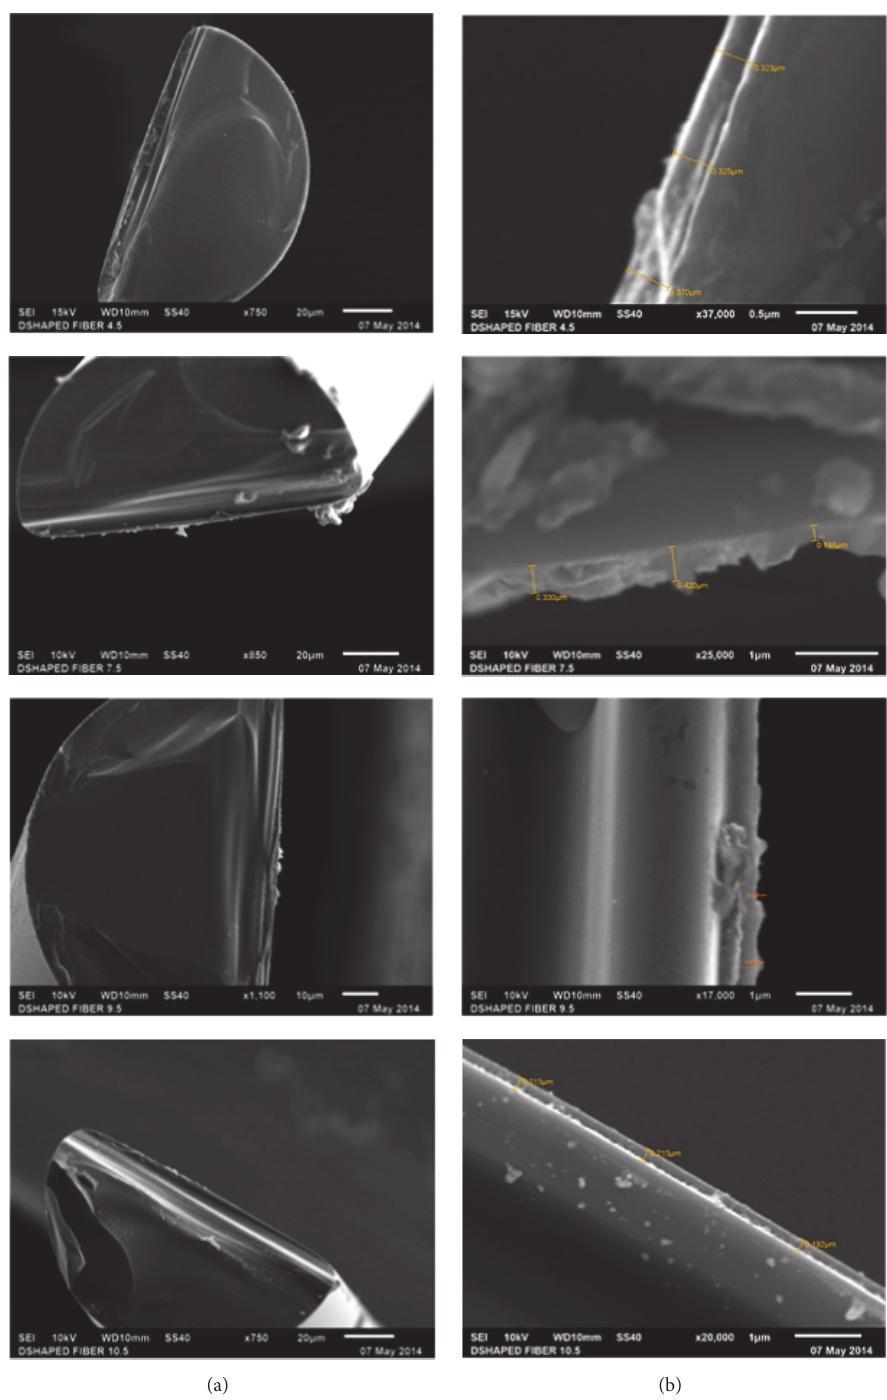
Figure 9: The SEM pictures of the D-shaped fiber coated with nanostructured metal oxide material (TiO 2 ). (a) is an amplified image of (b). The mean values of the resultant thickness measurement are shown in Figure 10.